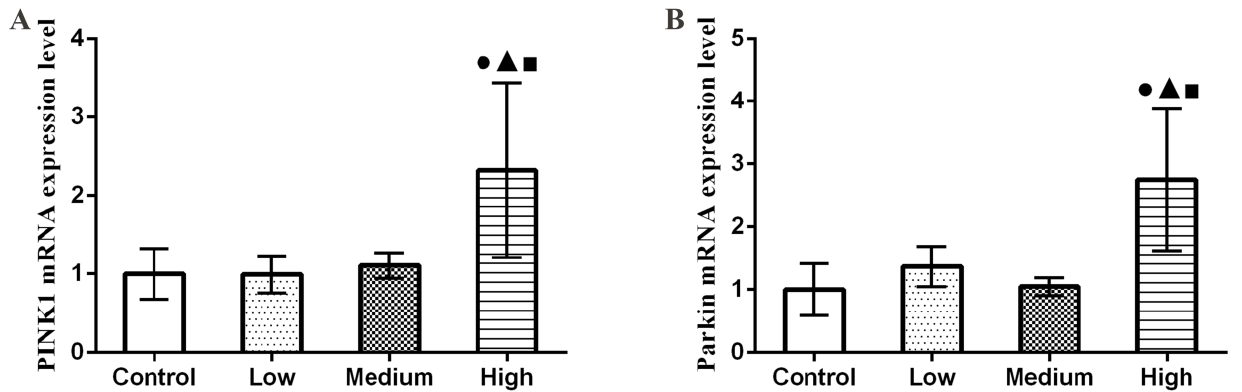
Figure 6. Changes of PINK1 and Parkin mRNA expression levels in rat lung tissue. ( A ) PINK1 mRNA expression level. ( B ) Parkin mRNA expression level. Note: ● , compared with the control group, p < 0.05; ▲ , compared with the low group, p < 0.05; ■ , compared with the medium group, p < 0.05.